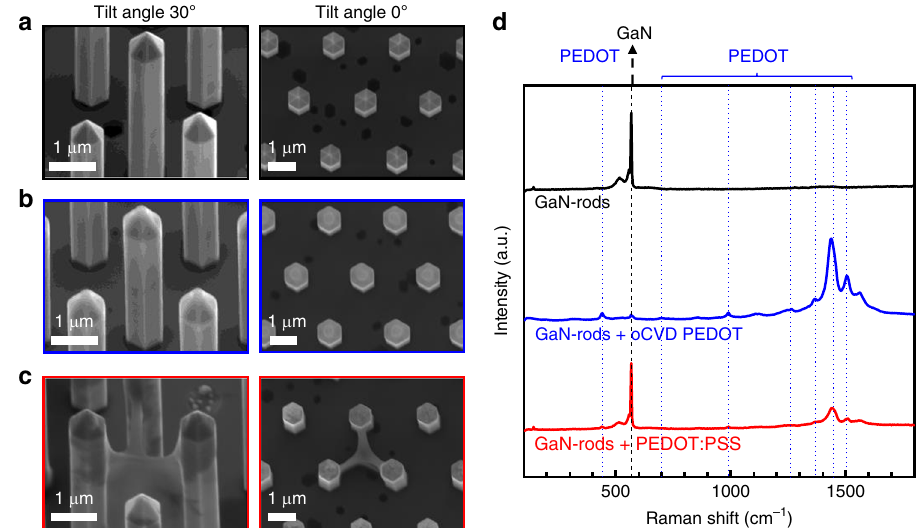
Fig. 1 SEM micrographs and Raman signals of uncoated and coated GaN-microrods. a Uncoated and b conformally coated microrods with organic PEDOT deposited via oxidative chemical vapor deposition (oCVD). c Nonconformal coverage of GaN-microrods with PEDOT:PSS via spin-coating in which surface tension effects lead to liquid bridging between three adjacent microrods (secondary electron map, tilt = 30°/0°, E PE = 5 kV, scale bars correspond to 1 µ m). d Corresponding Raman signals reveal the characteristic GaN peak (dashed, black) and PEDOT peaks (dotted blue) for the coated